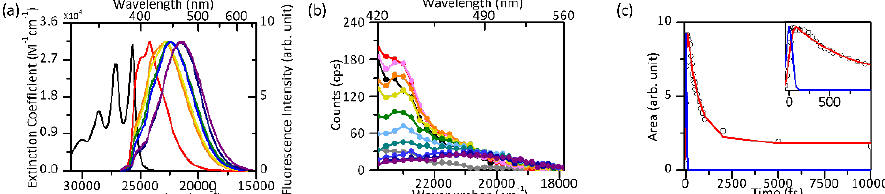
Fig. 1. (a) Absorption (black) and fluorescence spectra of BA in several solvents: red, heptane; orange, propanol; yellow, ethanol; green, methanol; blue, acetone; navy, acetonitrile; purple, ethylene glycol. (b) TFS of BA in acetonitrile: Grey, -50 fs; black, 0 fs; red, 50 fs; pink, 100 fs; orange, 200 fs; yellow, 300 fs; green, 500 fs; sky-blue, 750 fs; cyan, 1 ps; blue, 2 ps; navy, 5 ps; and purple, 10 ps. Excitation wavelength was 380 nm. (c) Area of TFS of BA in acetonitrile: black dots are experiment, red line is the fitting results, and the blue line is the instrumental response function. The inset indicates the same data from -50 fs to 1